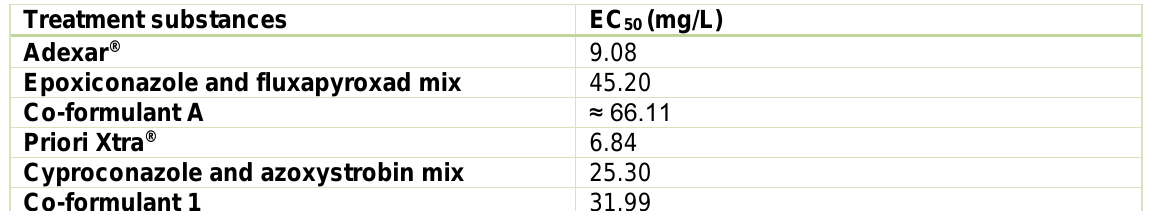
Table 3: EC 50 values obtained from best fit values of a non-linear dose-response curve of Adexar ® , Priori Xtra ® and their active substances mix; co-formulant A; co-formulant 1 treatment on HepaRG cells